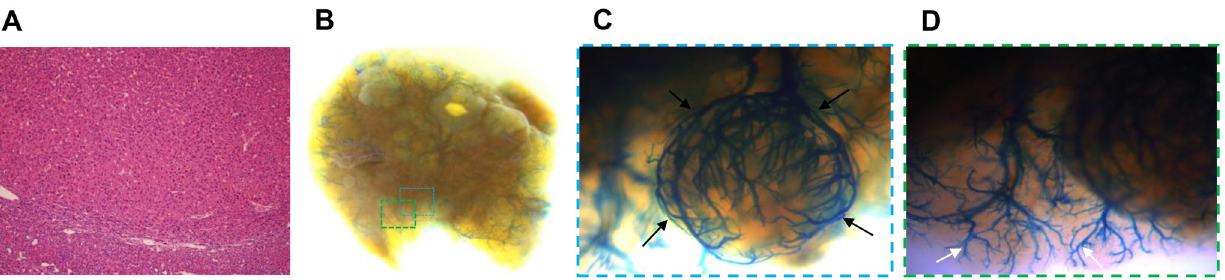
Fig 4. Selective latex arteriography of an Albumin-Cre/MST1 fl/fl /MST2 fl/fl mouse that developed multiple spontaneous hepatocellular carcinomas. (A) Histologic examination (hematoxylin and eosin staining, ×100). (B) The whole liver and (C, D) magnified images from a surgical microscope display a hypervascular mass supplied by feeding arteries (black arrow) and enlarged prominent arteries (white arrow) in the tumor-free background liver. The dotted box in (B) indicates the region magnified in (C, D).